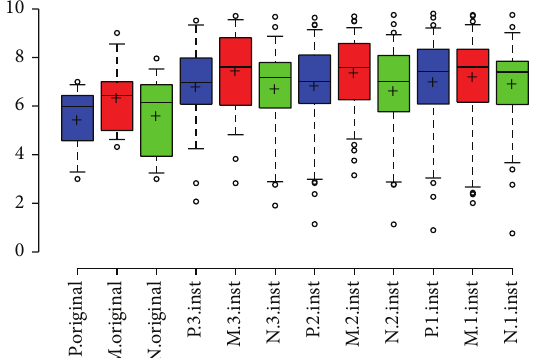
Figure 2: NH listeners with CI simulation enjoyment by number of instruments. NH listeners preferred modified segments comprised of a single instrument, two instruments, or three instruments compared to the original music sample. P: pleasant, N: natural, M: sounds like music, and Inst: instruments. Center lines show the medians, box limits indicate the 25th and 75th percentiles, whiskers extend to 5th and 95th percentiles, outliers are represented by dots, and crosses represent sample means.